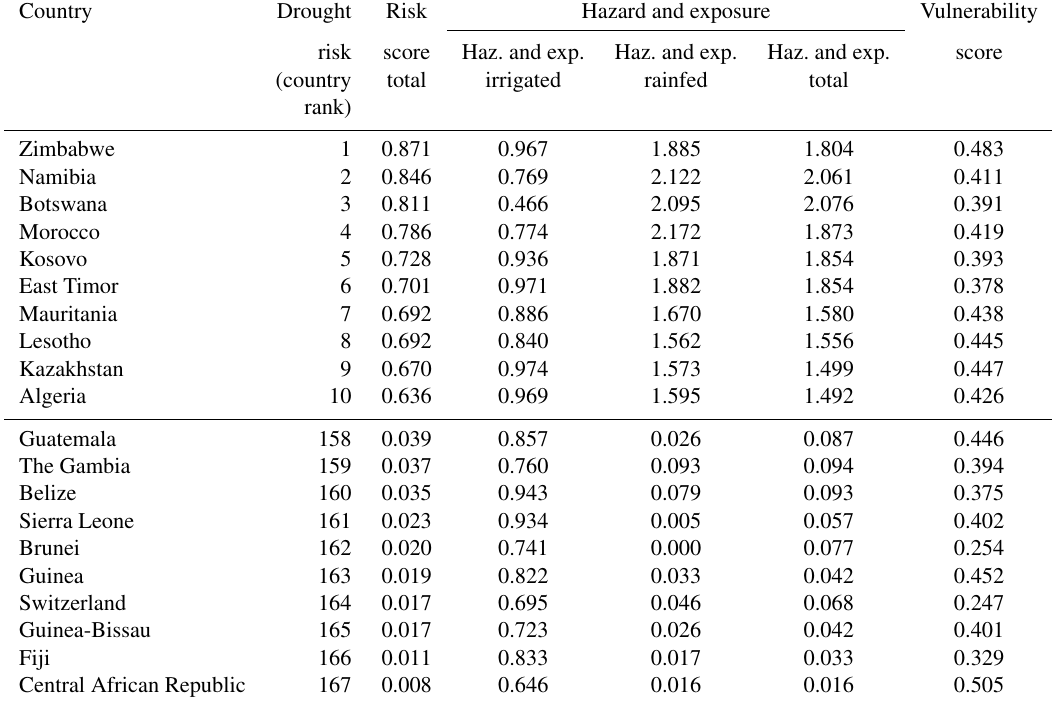
Table 3. Rank of countries with the highest and lowest risk of drought for combined agricultural systems (rainfed and irrigated). Country Drought Risk Hazard and exposure Vulnerability risk score Haz. and exp. Haz. and exp. Haz. and exp. score (country total irrigated rainfed total rank) Zimbabwe 1 0.871